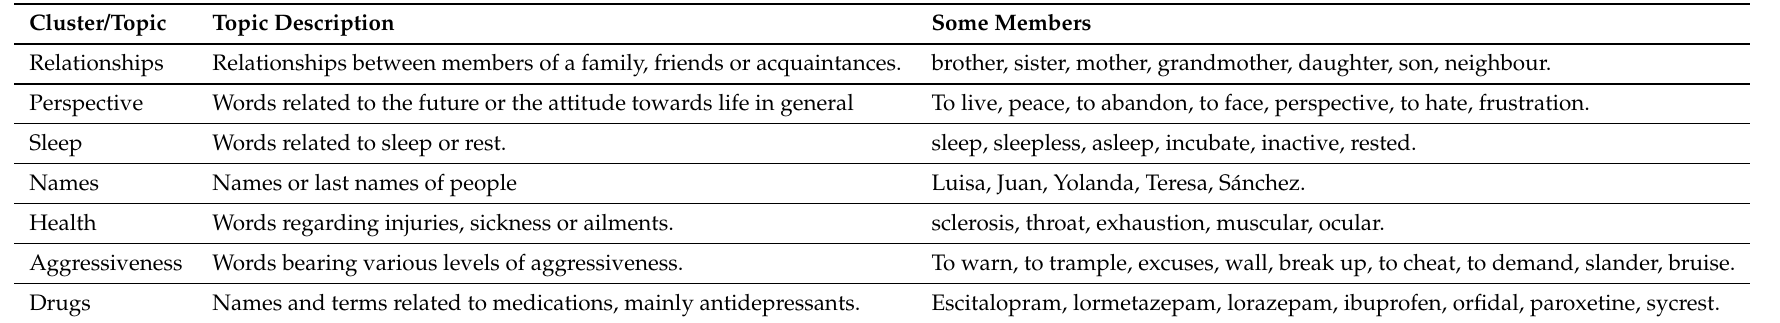
Table 1. Description of clusters depicted in Figure 5 including some